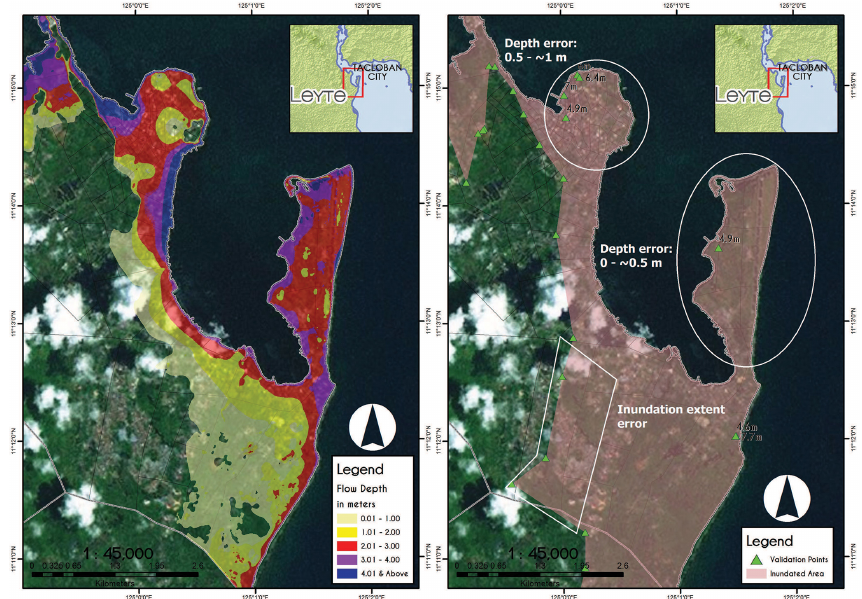
Figure 3. Error in height and extent of inundation (left panel: simulation result, right panel: survey result).